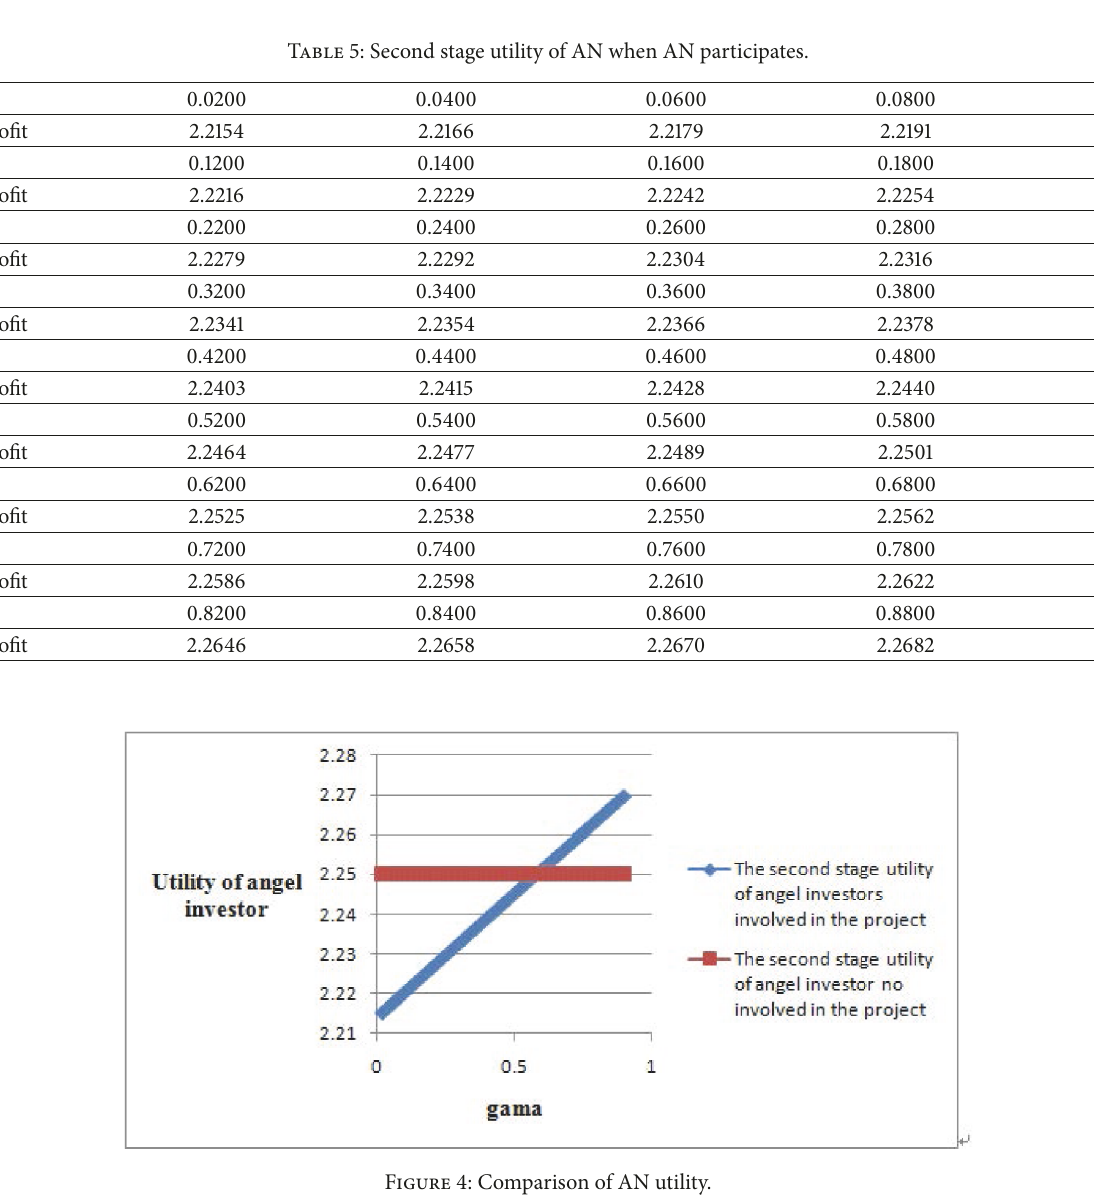
Figure 4: Comparison of AN